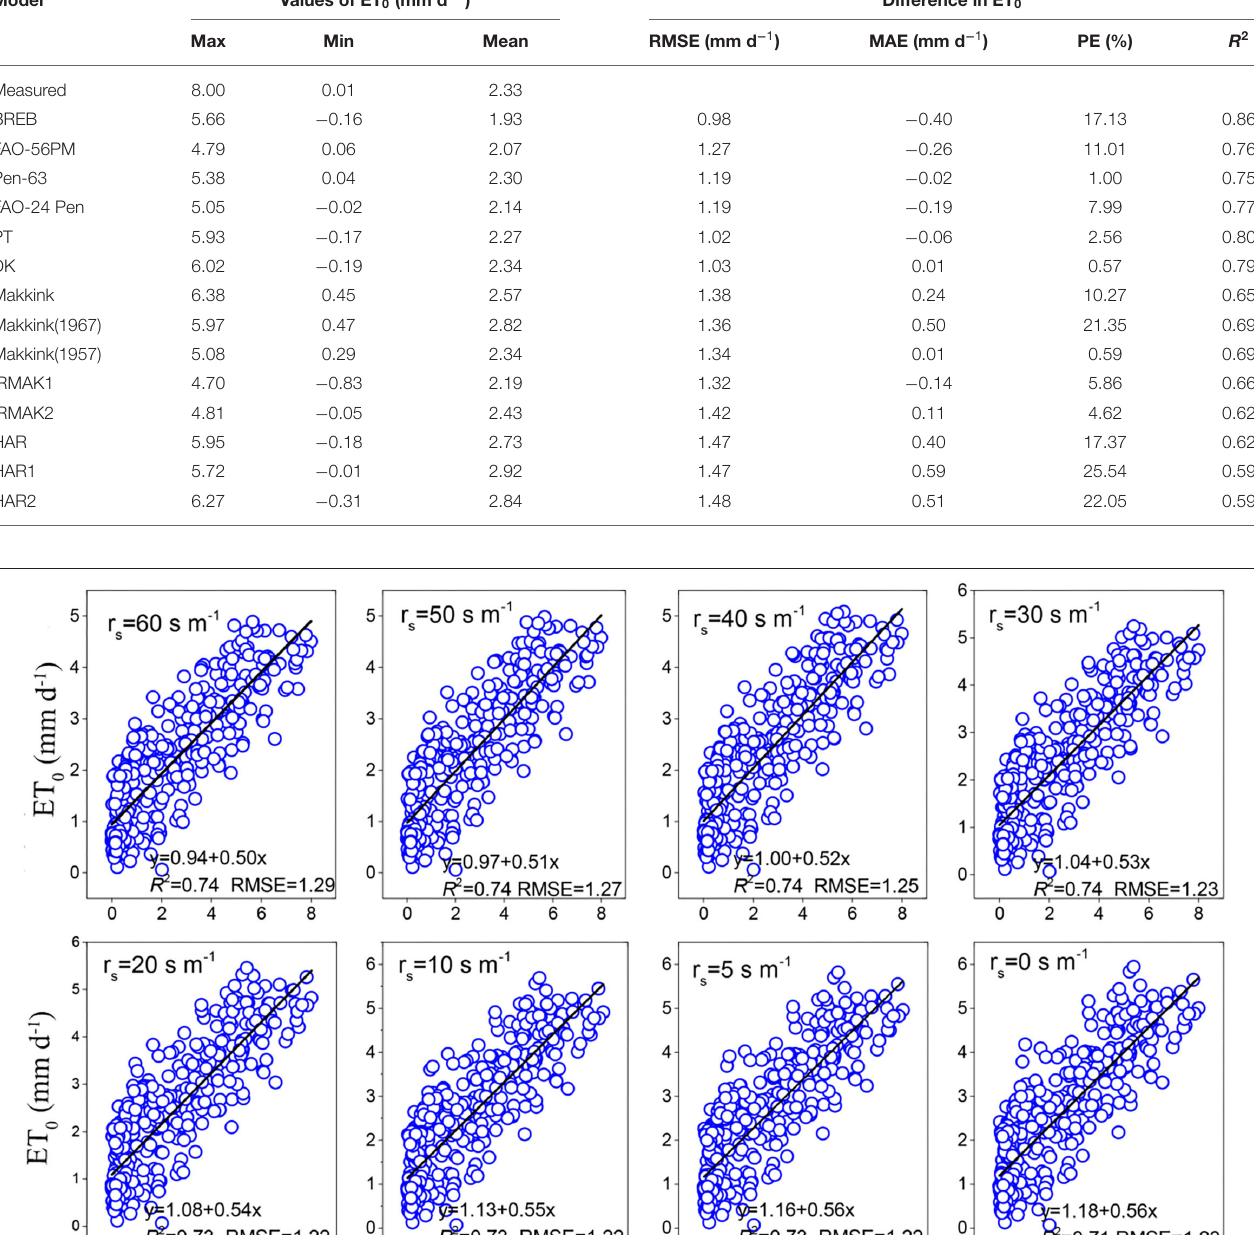
> HAR1 (1.47) > HAR2 (1.48). The best model was 34%